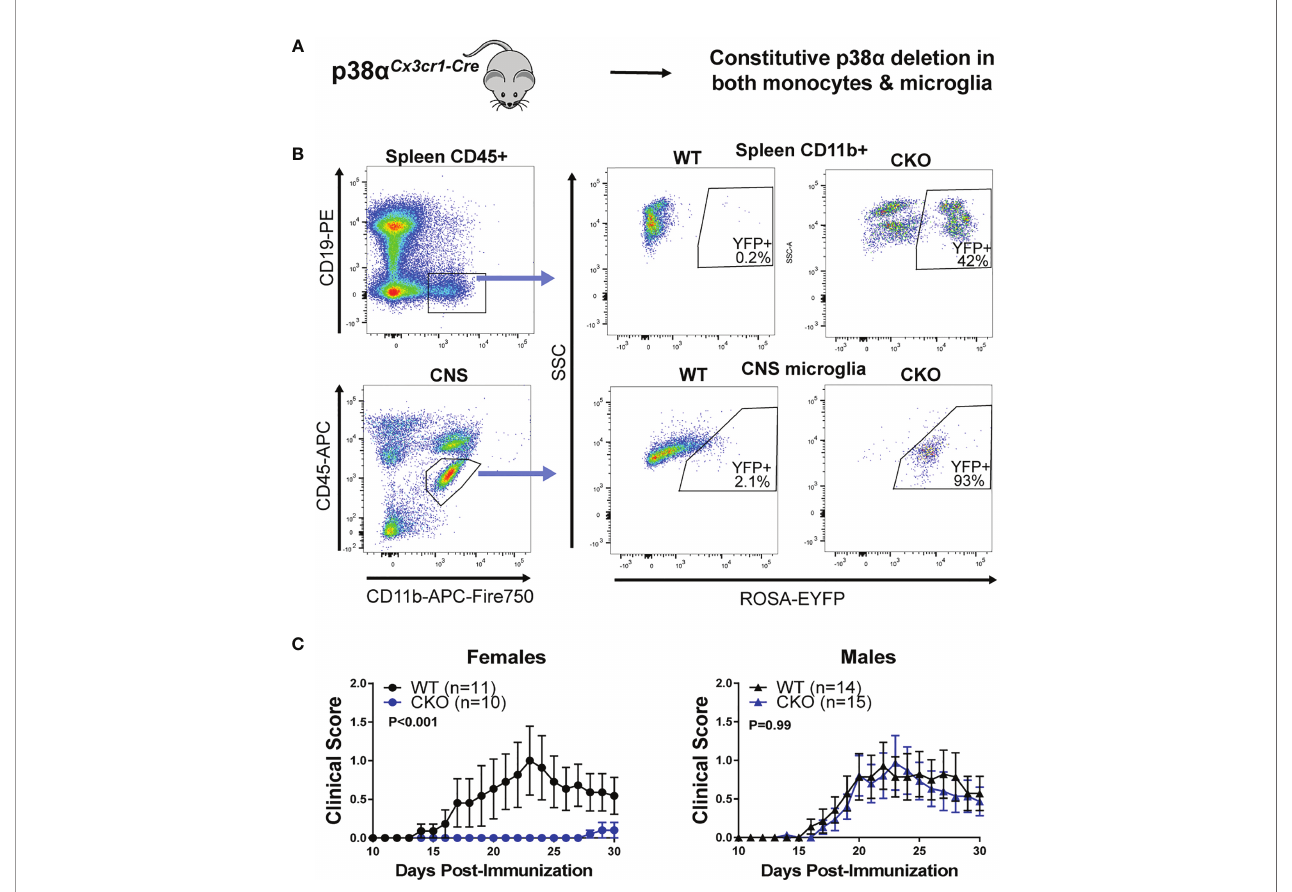
FIGURE 1 | Combined peripheral myeloid and microglial deletion of p38 a reduces EAE severity in only in female mice. (A) A schematic illustrating the approach to targeting of genetic deletion to speci fi c cell types used in Figure 1. (B) Spleen cells and CNS cells were isolated from male naïve p38 a CKO Cx3cr1 ROSA-EYFP+ mice as described in the Materials and Methods and analyzed by fl ow cytometry. Top panel shows reporter EYFP expression in spleen myeloid cells (CD45 + CD19 - CD11b + ) from CKO (p38 a CKO Cx3cr1 ROSA-EYFP+) or WT (p38 a fl / fl Cx3cr1-Cre-negative ROSA-EYFP+ littermates) mice. Bottom panel shows EYFP expression in CNS microglia (CD11b + CD45 INT ). (C) EAE was induced and evaluated in female and male p38 a CKO Cx3cr1 and WT control mice (p38 a fl / fl Cx3cr1-Cre-negative littermates) as described in Materials and Methods. P value indicates signi fi cance of difference in overall EAE course between WT and CKO, calculated by two-way ANOVA, as detailed in Materials and Methods. Sample size for each sex/genotype is indicated in parentheses in the panel